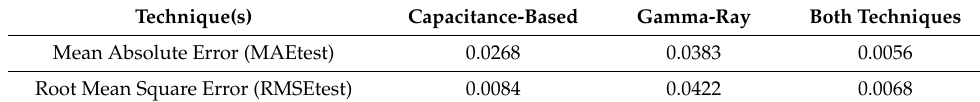
Table 2. ANN relative-error criterion of three techniques.